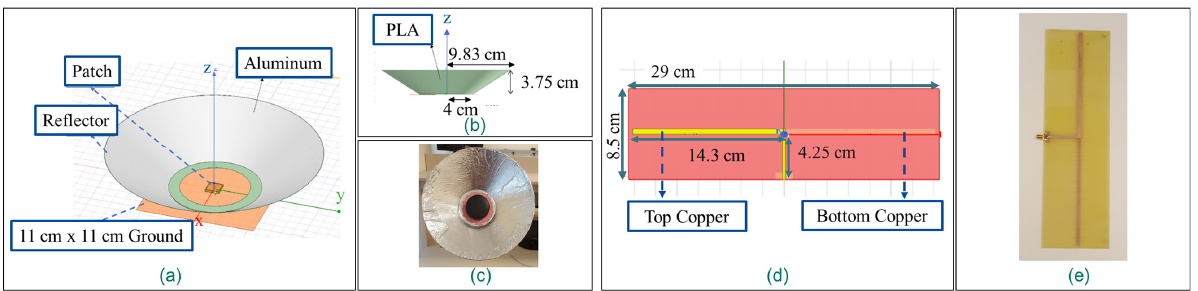
Figure 5. Modelled directional GPS antenna ( a , b ), fabricated directional GPS antenna ( c ), modelled 433 MHz dipole antenna ( d ), fabricated 433 MHz dipole antenna ( e ).